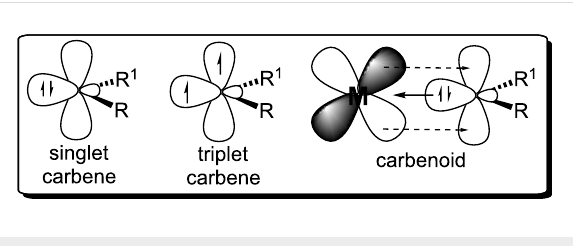
Figure 1: Singlet carbene, triplet carbene and carbenoids.